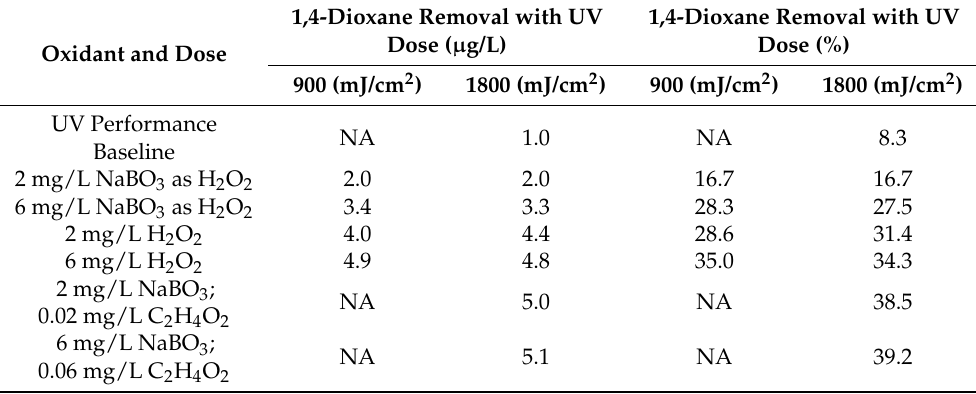
Table 2. 1,4-Dioxane Initial Screening Results Summary (10 µ g/L initial 1,4-dioxane conc.).